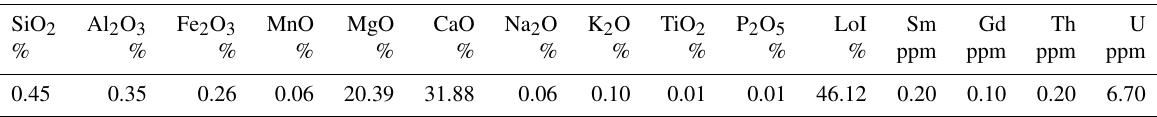
Table 3. Elemental composition of the dolomite sample Err8. SiO 2 Al 2 O 3 Fe 2 O 3 MnO MgO CaO % % % % % % % % % ppm ppm ppm ppm 0.45 0.35 0.26 0.06 20.39 31.88 0.06 0.10 0.01 0.01 46.12 0.20 0.10 0.20